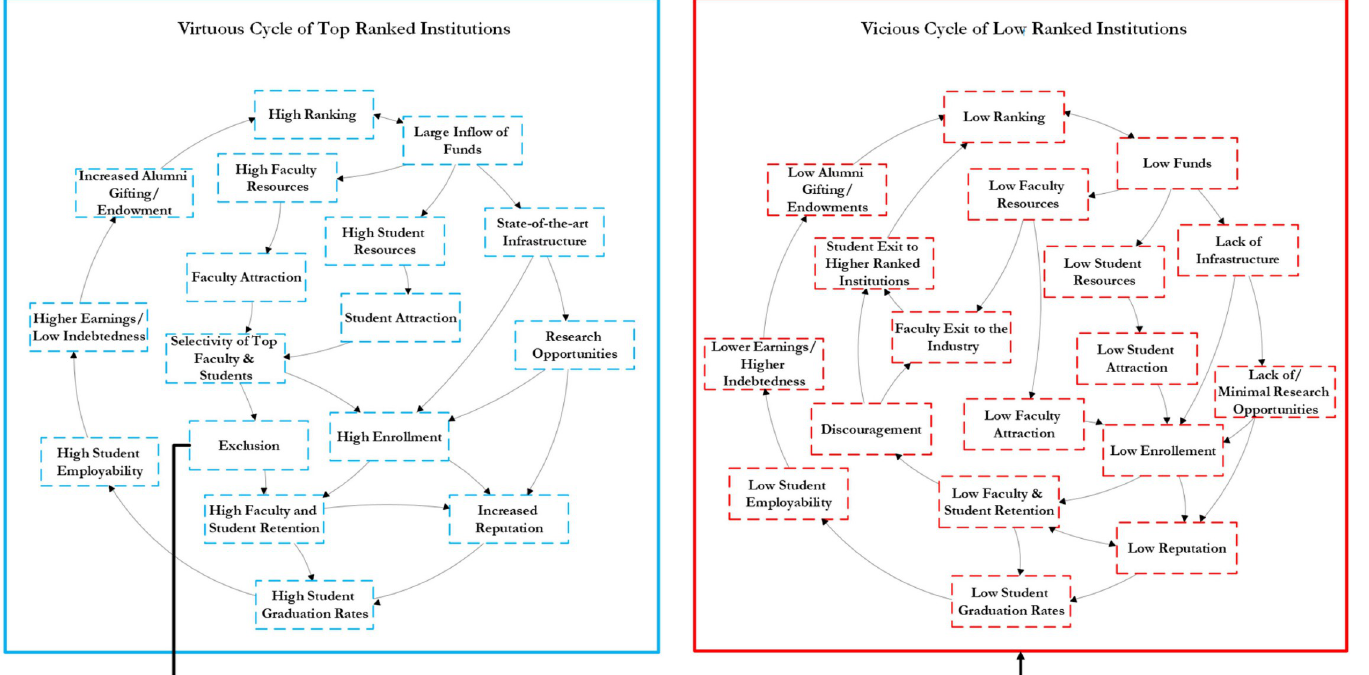
Fig 4. The virtuous cycle of high-ranked institutions and the vicious cycle of low-ranked institutions.